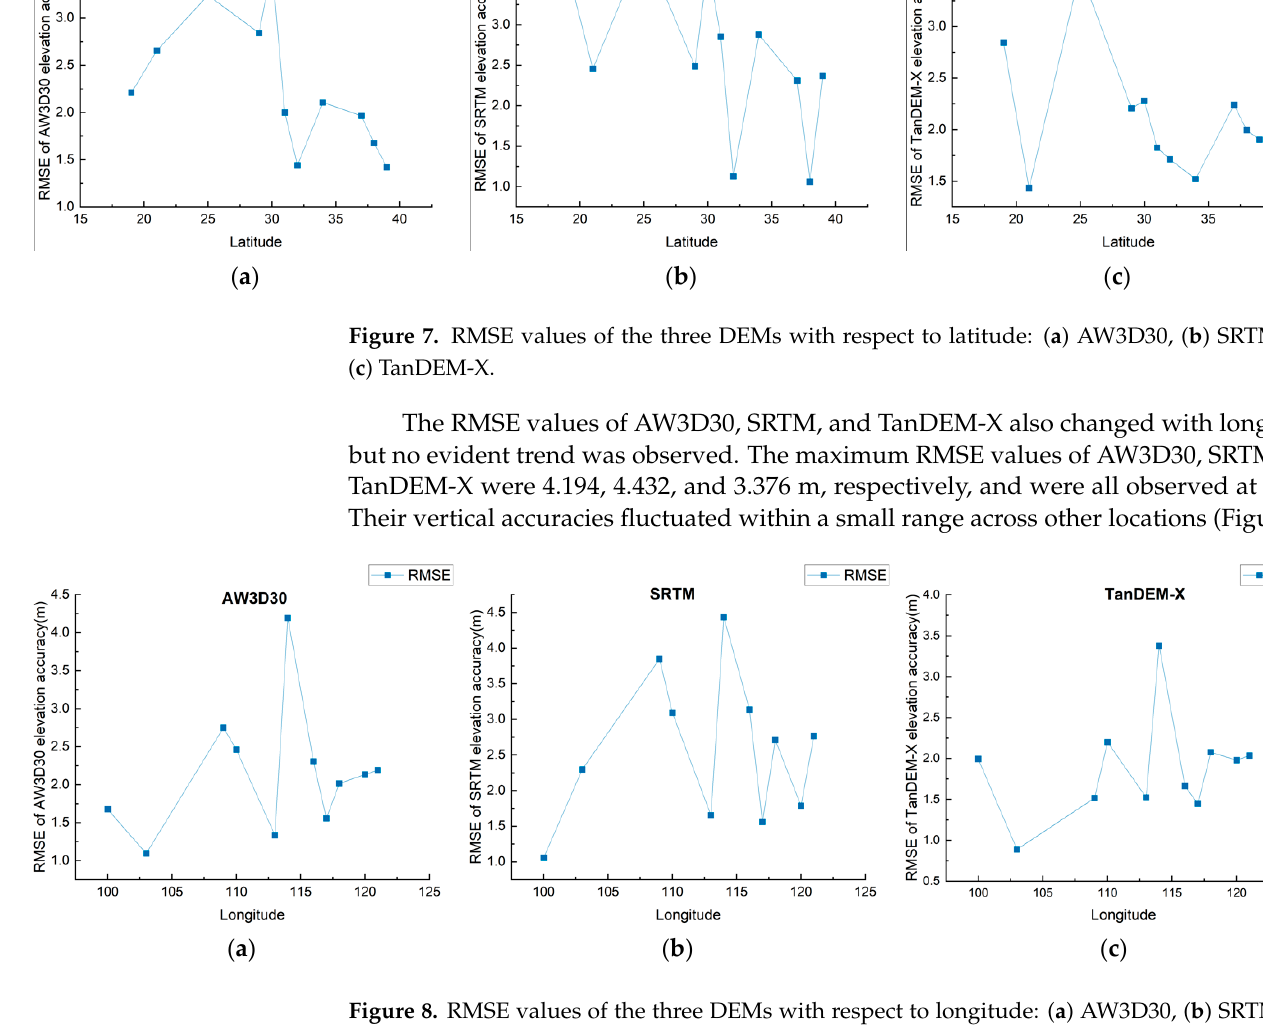
Table 6. Kruskal–Wallis test on latitudes and longitudes.